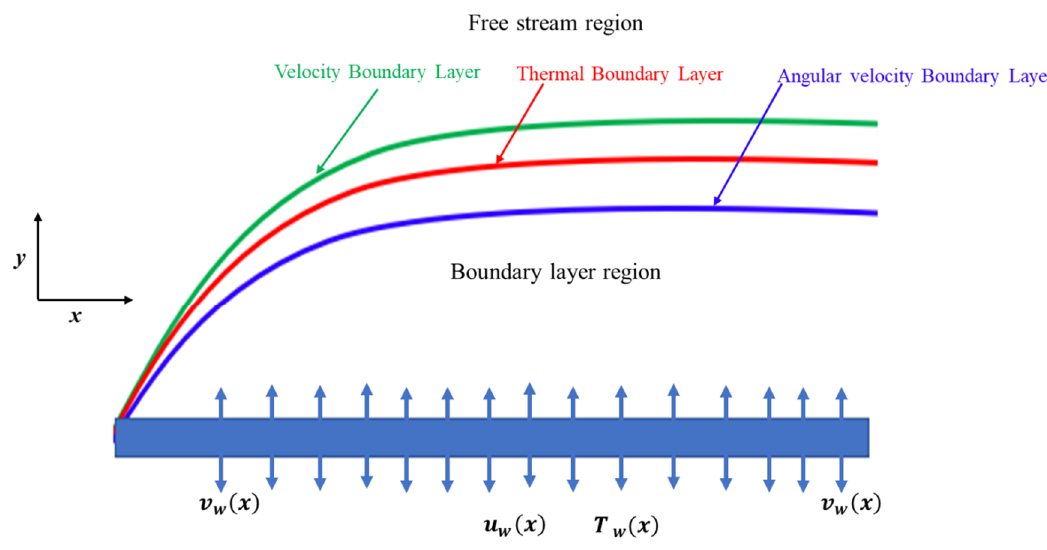
Figure 1. Flow of problem and coordinate system.